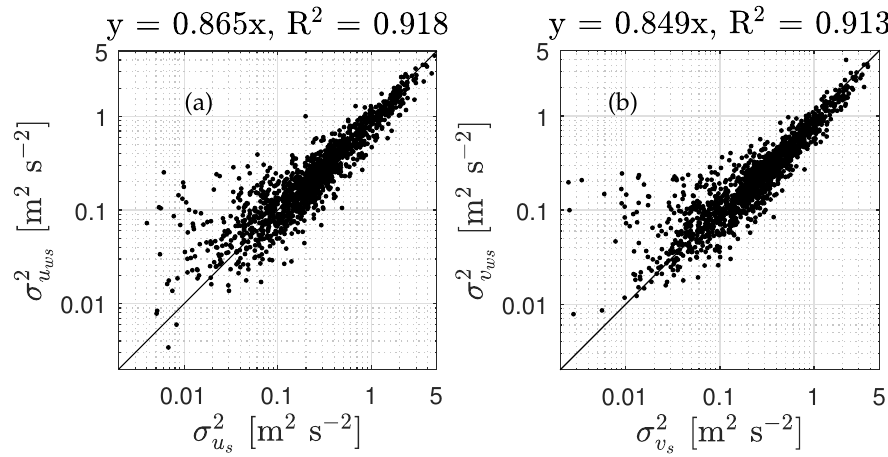
Figure 9. Scatter plot of the horizontal velocity-component variances of the WindScanners and the sonic anemometer. The results for the u - and v -velocity components are shown in frames ( a ) and ( b ), respectively. The results of a linear regression through the origin are also shown together with the coefficient of determination R 2 .